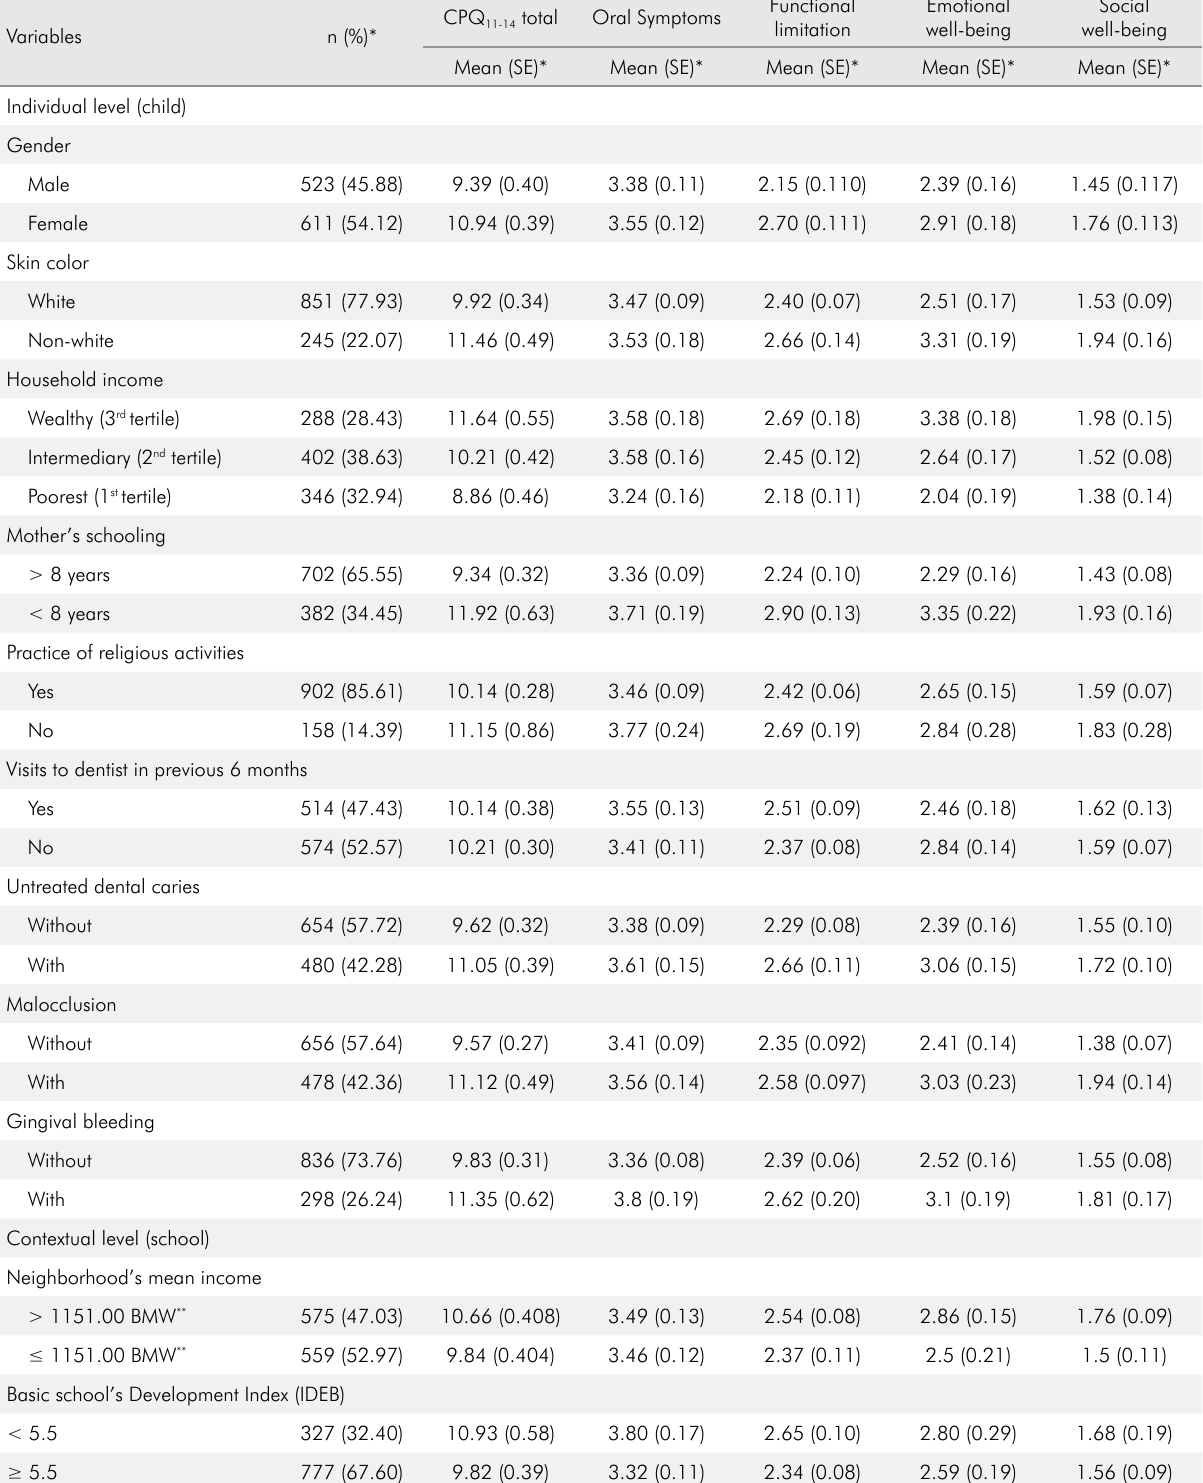
Table 1. Descriptive distribution of overall and domain-specific CPQ11–14 scores according to individual and contextual level characteristics of the sample: 1,134 12-year-old children, Santa Maria – RS,